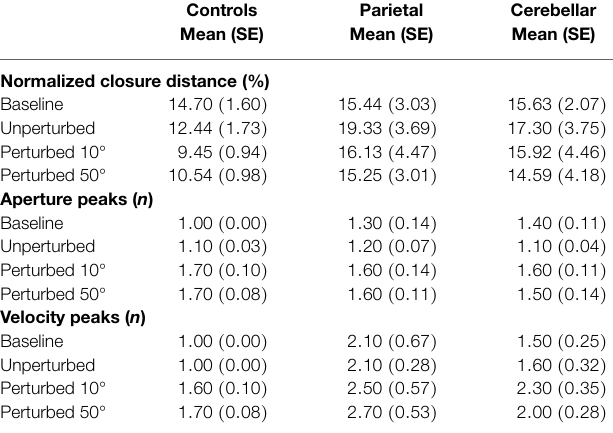
Controls Mean (SE)